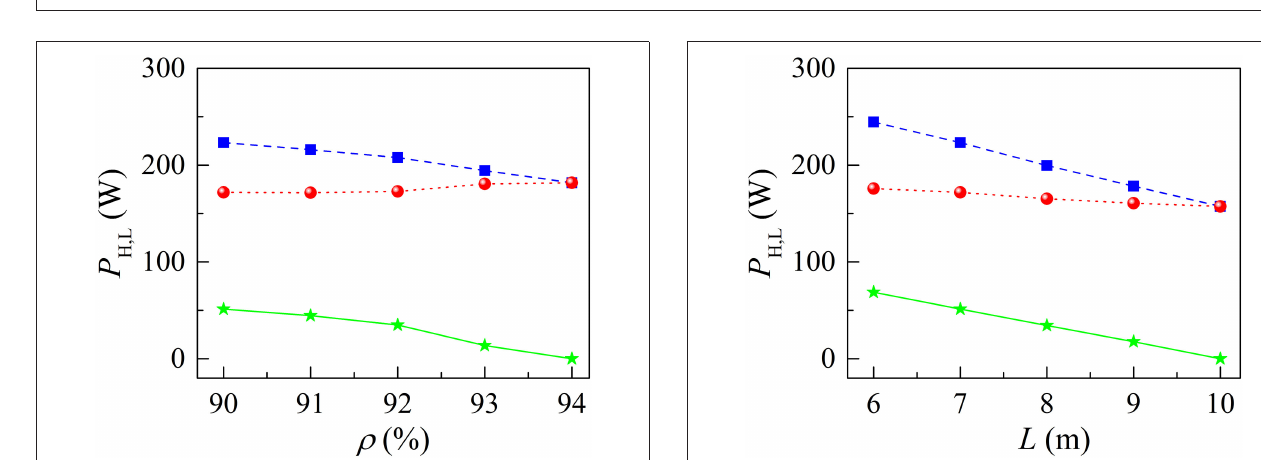
FIGURE 4 | The evolution of pulse temporal profiles as a function of E sat . (A) The pulse profiles with the upper peak power. (B) The pulse profiles with the lower peak power.